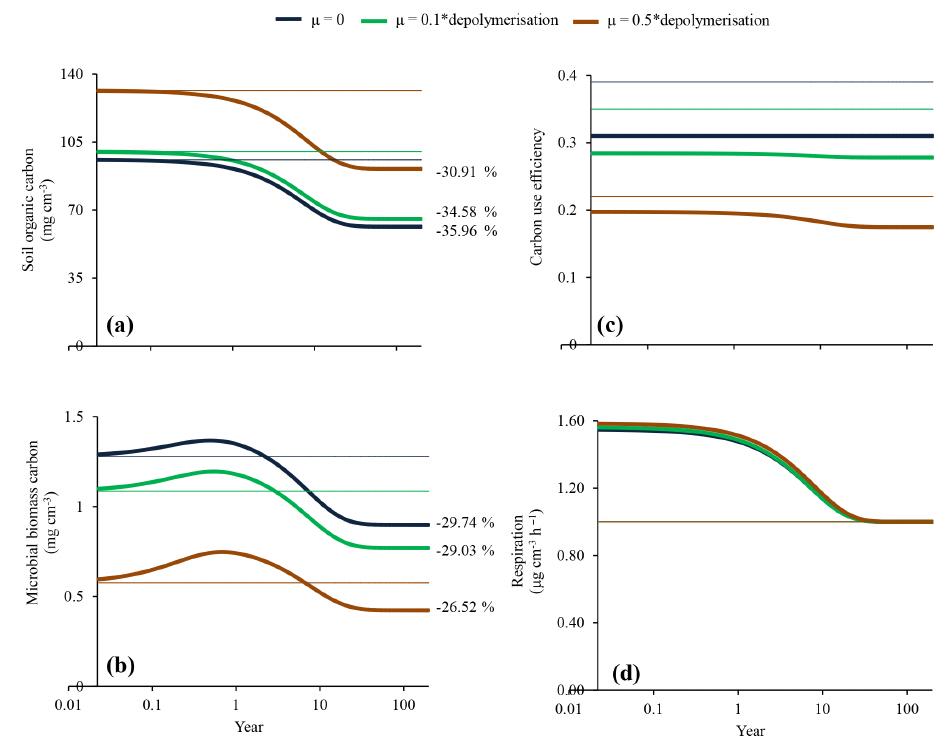
Figure 4. Long-term responses of optimised enzyme production (OPT) model to a 5 ◦ C warming in (a) soil organic carbon, (b) microbial biomass carbon, (c) CUE, and (d) respiration operating at different relative enzyme production costs ( µ , see Eq. 16). Thick lines represent warming response and thin lines represent corresponding equilibrium at the reference